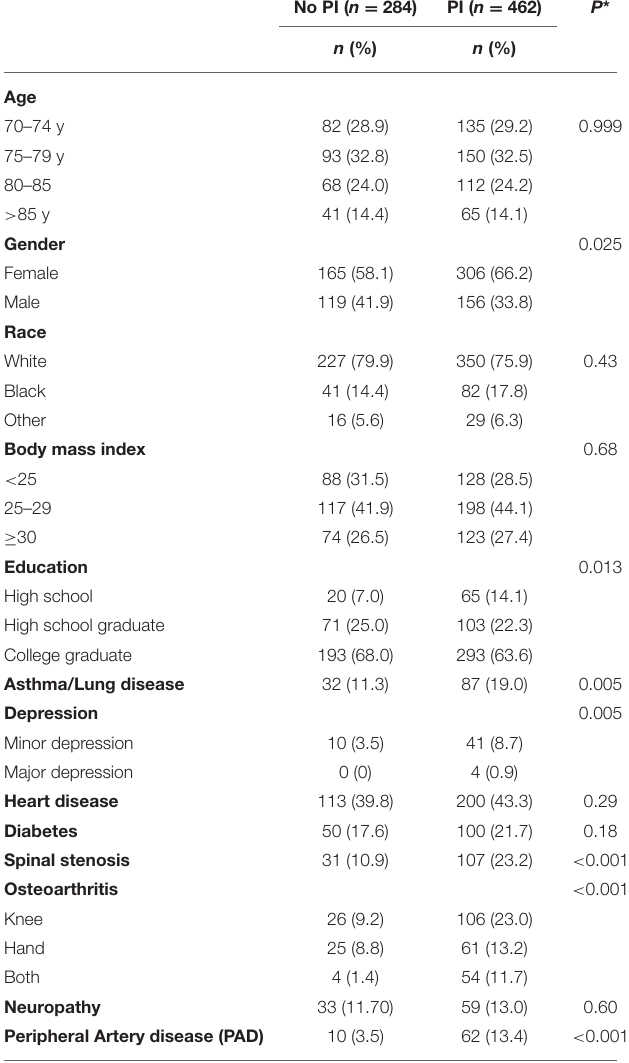
TABLE 1 | Participant characteristics according to pain interference (PI), MOBILIZE Boston Study,